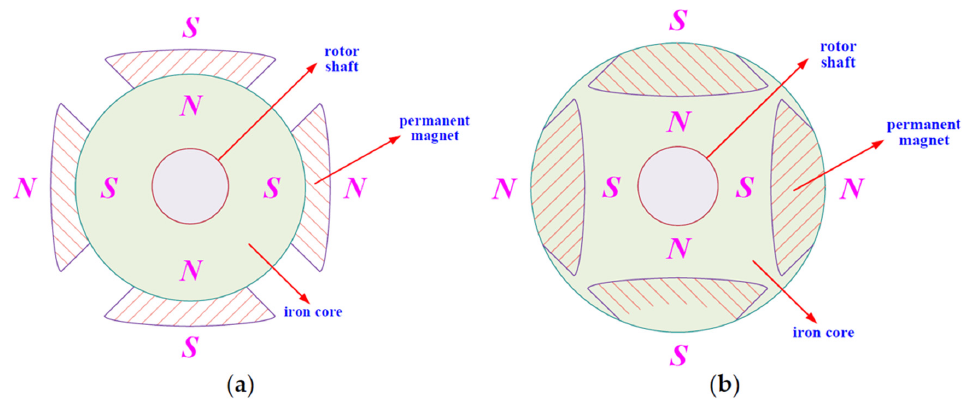
Figure 1. Structure and classification of the permanent magnet synchronous motor types: ( a ) SPMSM; ( b )